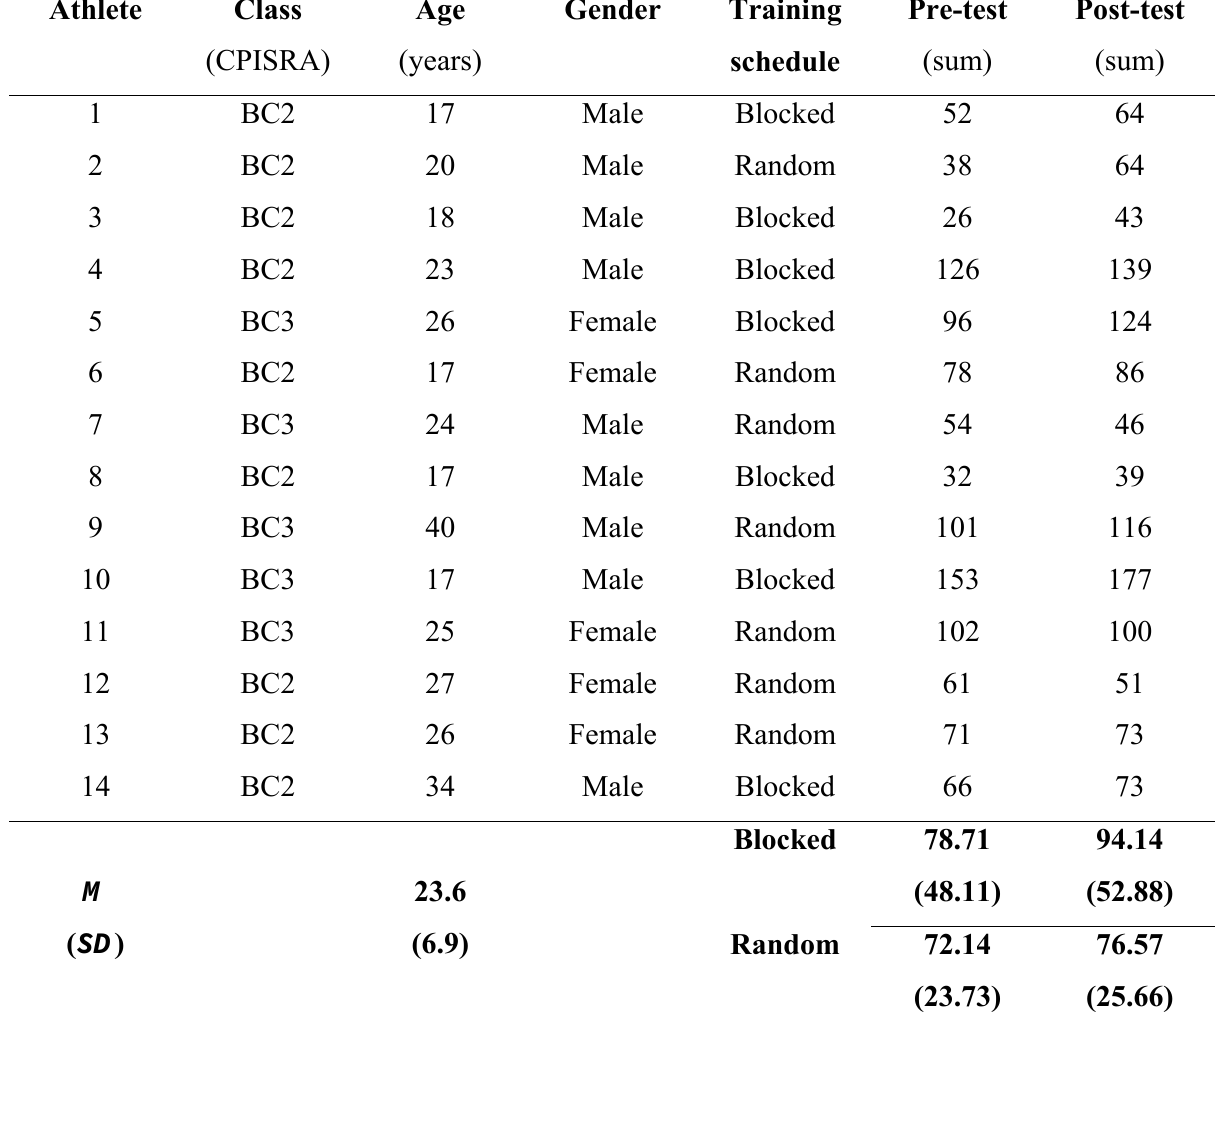
Athlete Characteristics, Intervention Training Schedule and Results from Pre- and